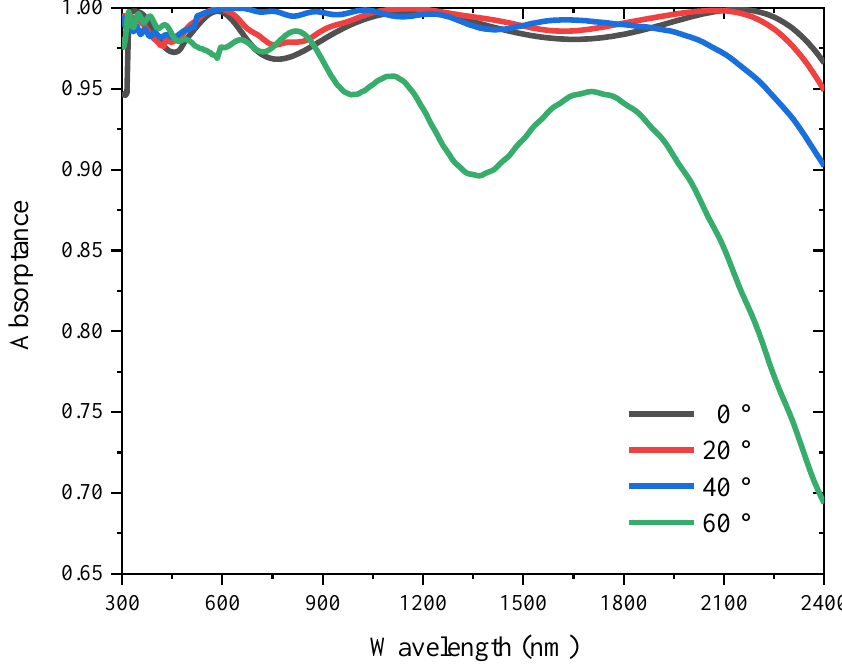
Figure 10. The absorption spectra of the default absorber with different incident angles.